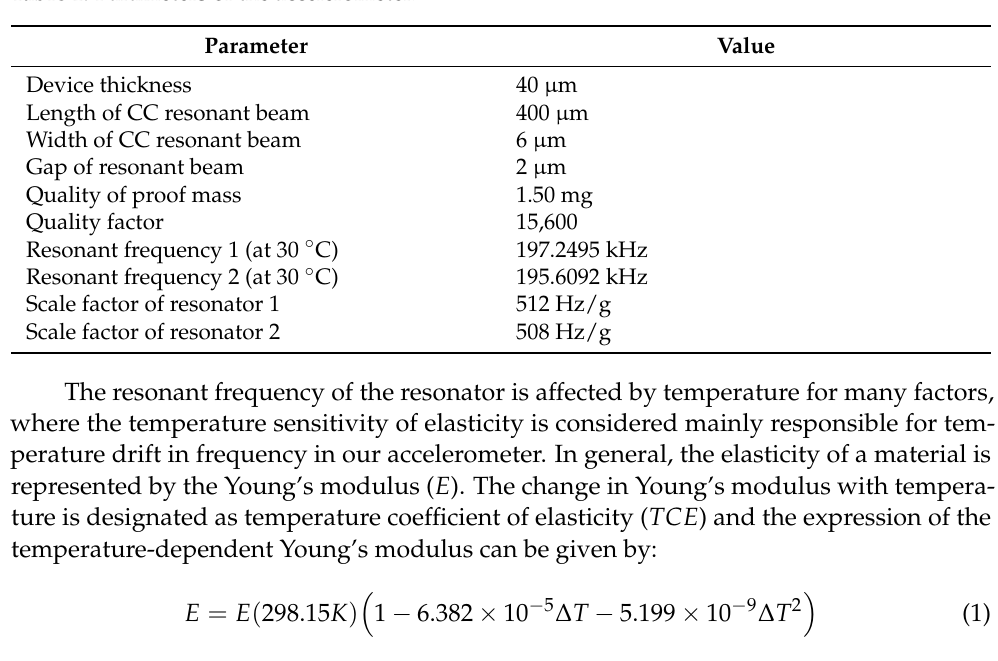
Figure 1. Schematic of the accelerometer. Table 1. Parameters of the